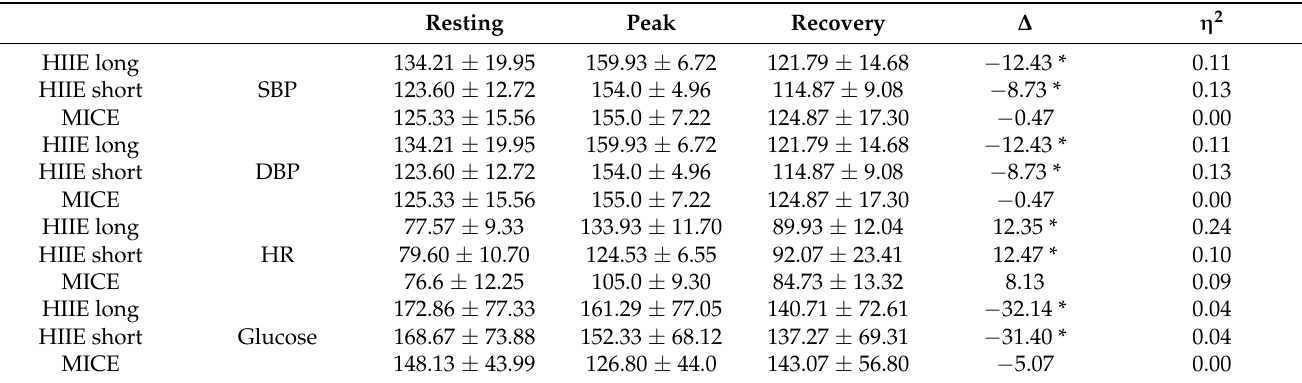
Table 3. Comparison of cardiovascular variables and blood glucose at rest, peak, and recovery from the evaluation of patients with DM2 organized by